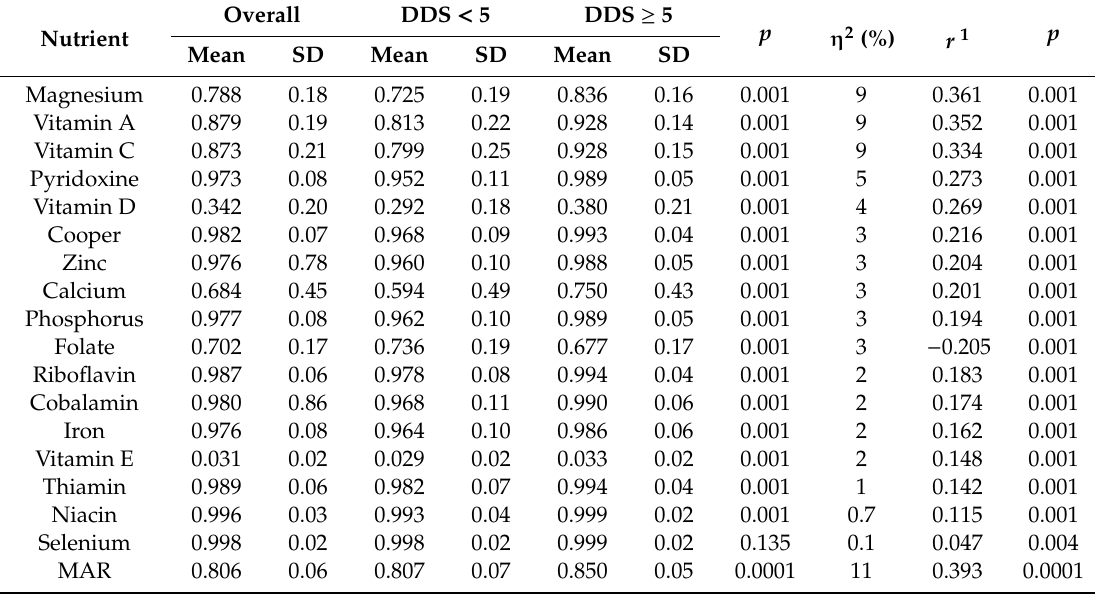
Table 5. Mean nutrient adequacy ratio of specific nutrients in